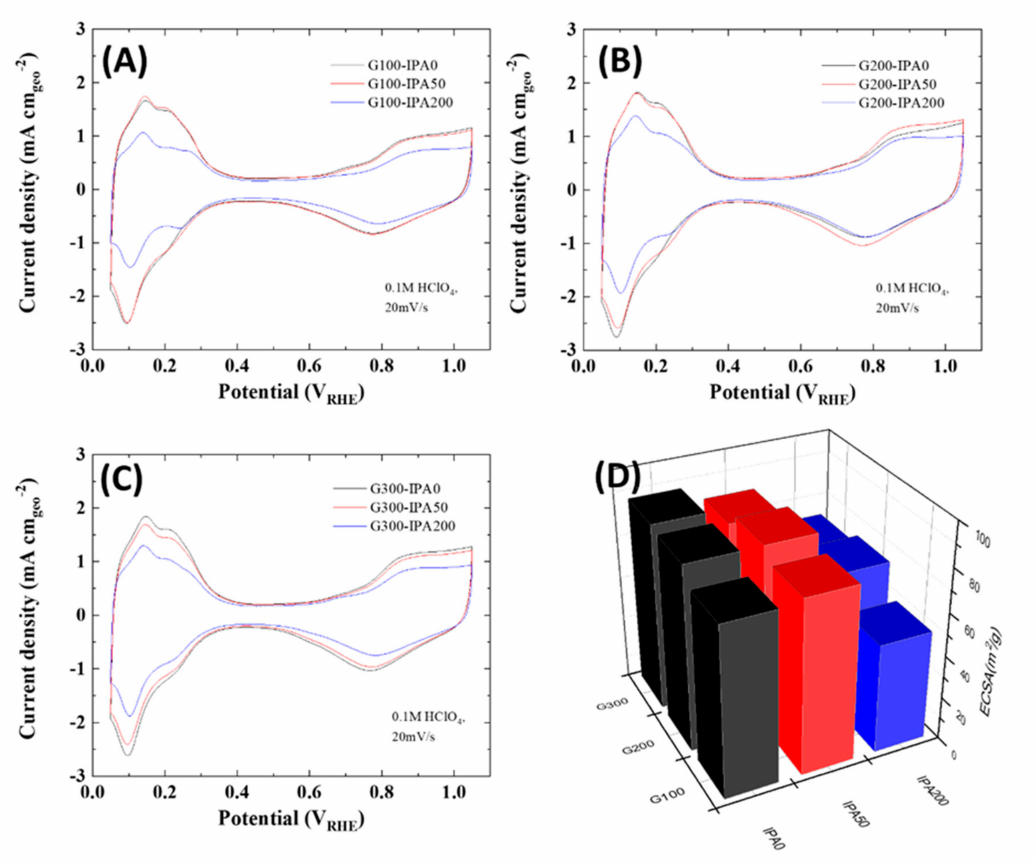
Figure 4. Cyclic voltammograms (CVs) of Pt / C catalysts synthesized using di ff erent IPA contents (0, 50, and 200 mL) in fixed amounts of glycerol of ( A ) G100, ( B ) G200, and ( C ) G300. ( D ) ECSAs of Pt / C catalysts according to the reaction